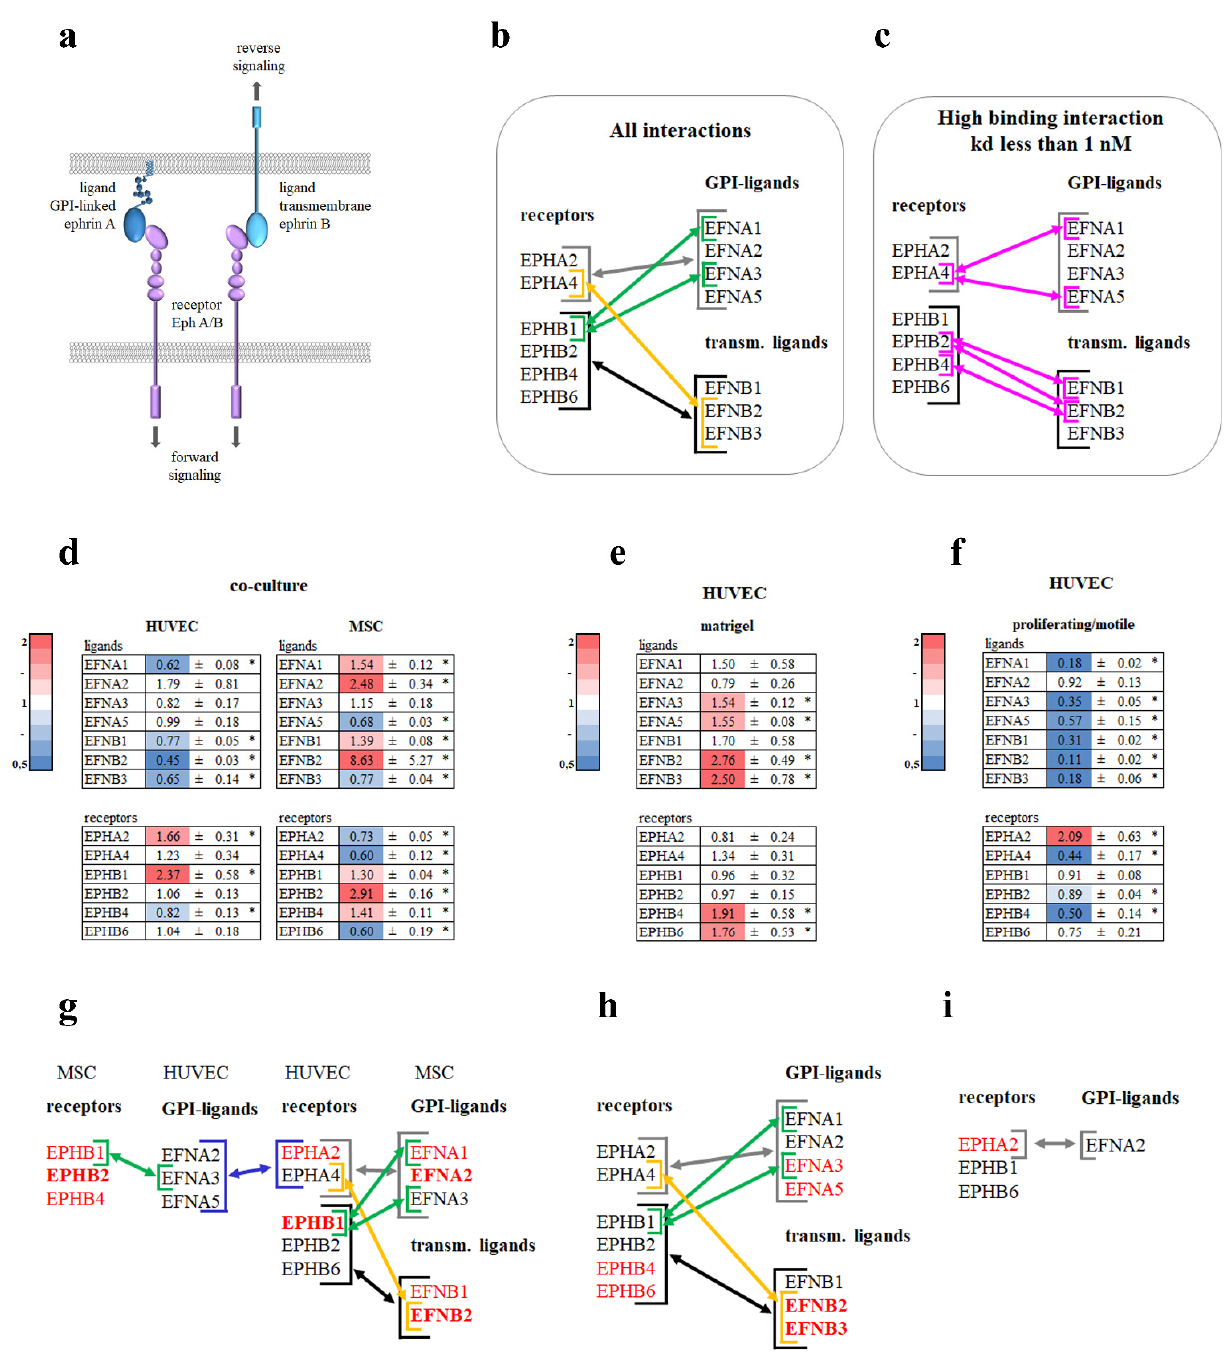
Figure 6. Analysis of EPH–EFN signaling genes. ( a ) Scheme illustrating EPH–EFN signaling. ( b ) Known interactions between EPH receptors and EFN ligands [21]. ( c ) High binding interactions, Kd <1 nM [19]. HUVECs were grown in co-culture with MSCs ( d ), on Matrigel TM ( e ), proliferat- ing/motile HUVECs ( f ), or a confluent monolayer for 19 h. Cells in direct co-culture were separated using anti CD31 magnetic beads. Total RNA was isolated and specific mRNA levels were quantified by qRT PCR as described in “Methods”. The data are presented as fold changes in the mRNA levels of HUVECs on Matrigel TM , in co-culture with MSCs, and proliferating/motile HUVECs compared to the mRNA levels for the same transcript in a confluent monolayer or to a monoculture for MSCs “*”: p < 0.05, n ≥ 3. Hypothetical scheme of EPH–EFN interactions in a co-culture of HUVECs and MSCs ( g ), HUVECs on Matrigel TM ( h ), and proliferating/motile HUVECs ( i ). Bold font indicates fold of upregulation